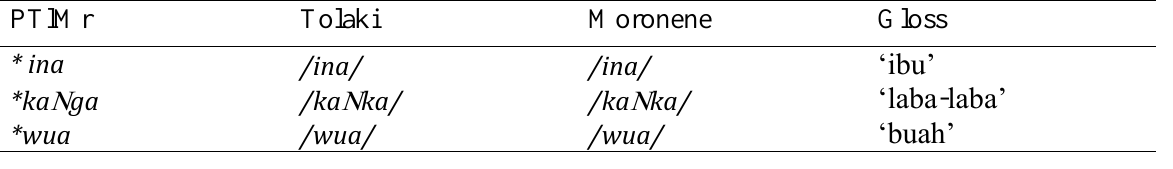
Table 3. The Final Word Position